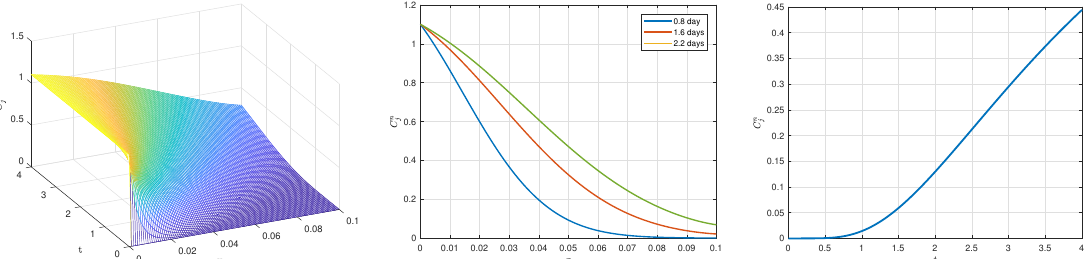
Figure 7. Numerical simulations obtained with α = 0.8. Left frame: H 2 concentration along axial direction at different space and time; Middle frame: the concentration profile of 0.8, 1.6, and 2.2 days; Right frame: H 2 profile at point x = 0.08 of the Zr 2 Fe bed.